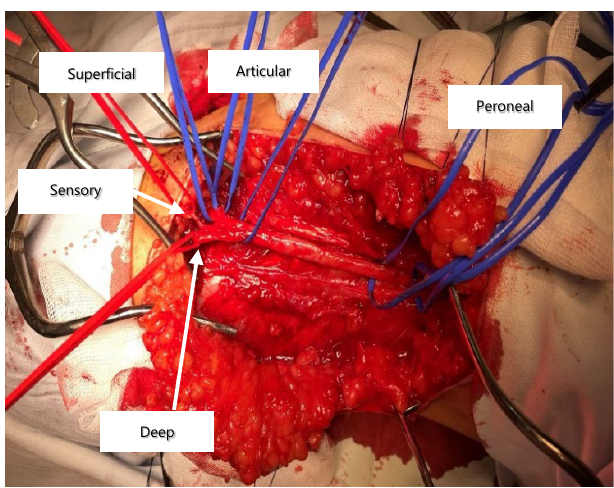
Figure . Mean Knowledge Score across Demographic